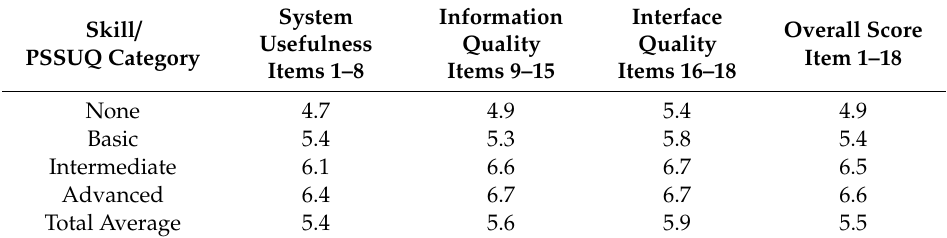
Table 4. Average scores for PSSUQ categories and technological skill levels.